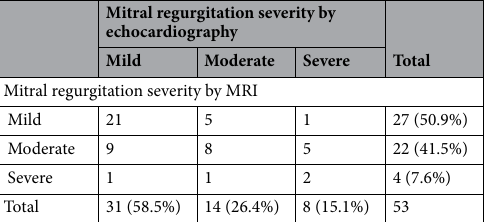
Mitral regurgitation severity by